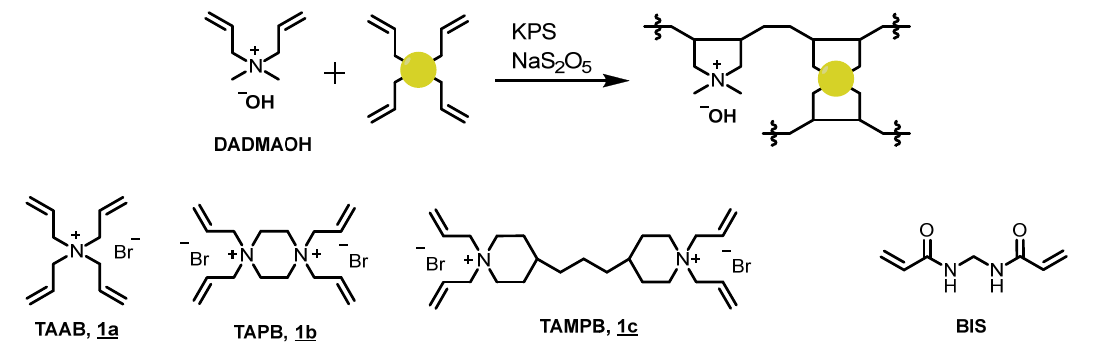
Figure 1. Top: general scheme for the crosslinking polymerization of DADMAOH; bottom: structures of the cross-linkers 1a – c and BIS used in this study.